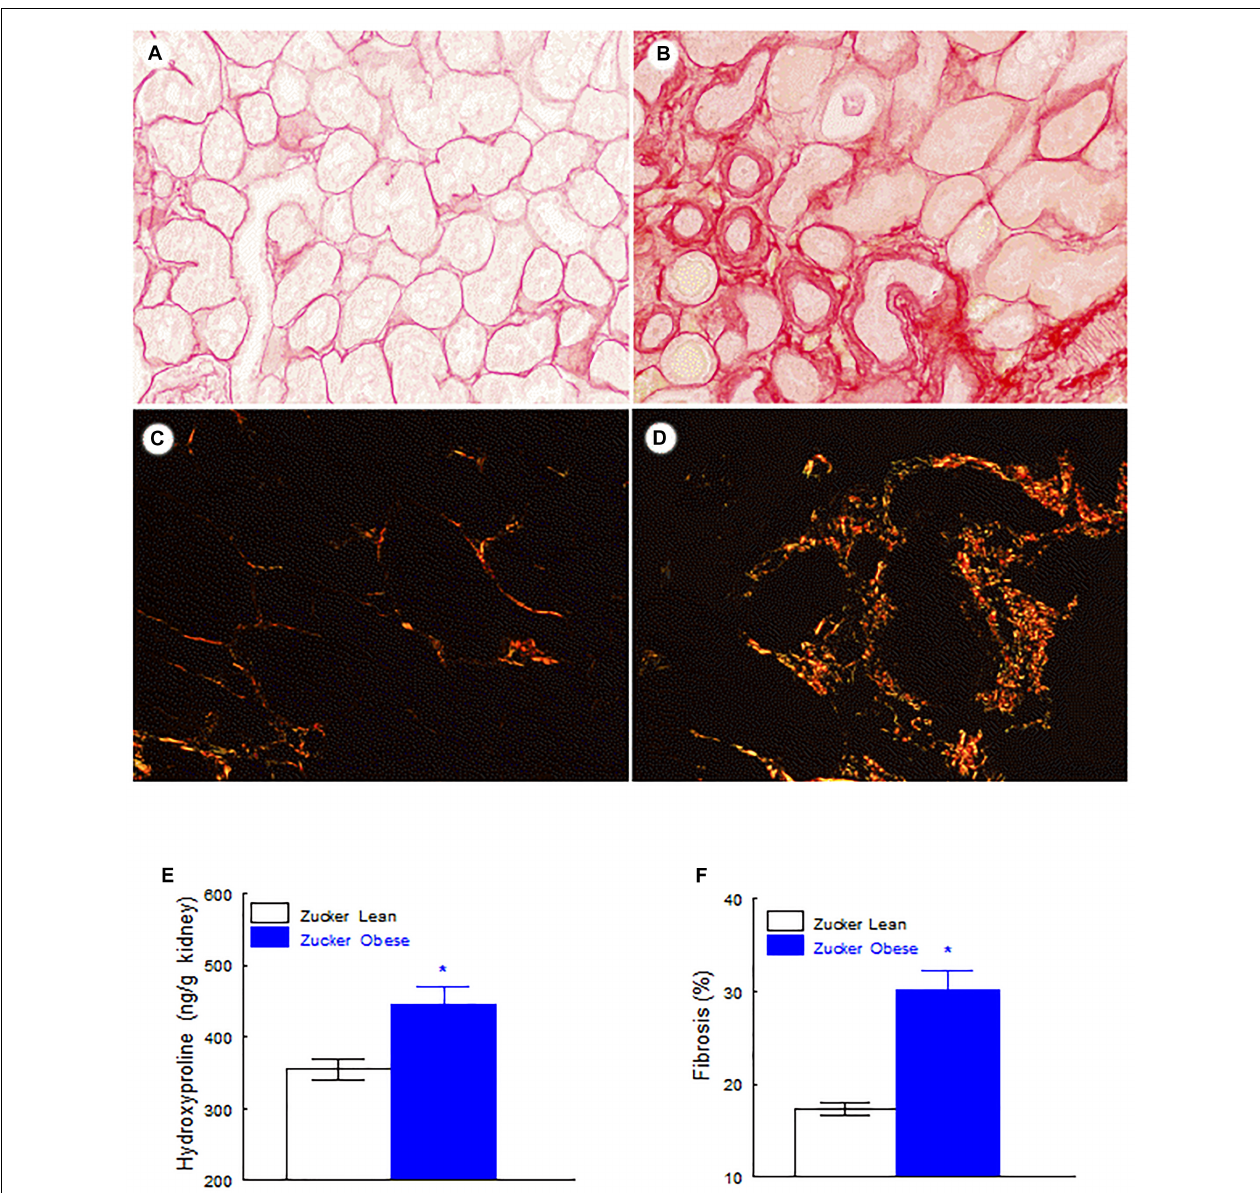
FIGURE 5 | Fibrosis related variables. Renal level of fibrosis in Zucker lean rats (A,C) and Zucker obese rats (B,D) , Note the significant increase of tubulointerstitial fibrosis in obese rats in comparison with lean rats ( A,B Sirius red stain with light microscope, C,D Sirius red stain with polarized light, original magnification 20 × ). Renal hydroxyproline levels (E) and percentage of renal fibrosis (F) . Data are means ± SEM. ∗ p < 0.01 compared with Zucker lean rats ( n = 10, each